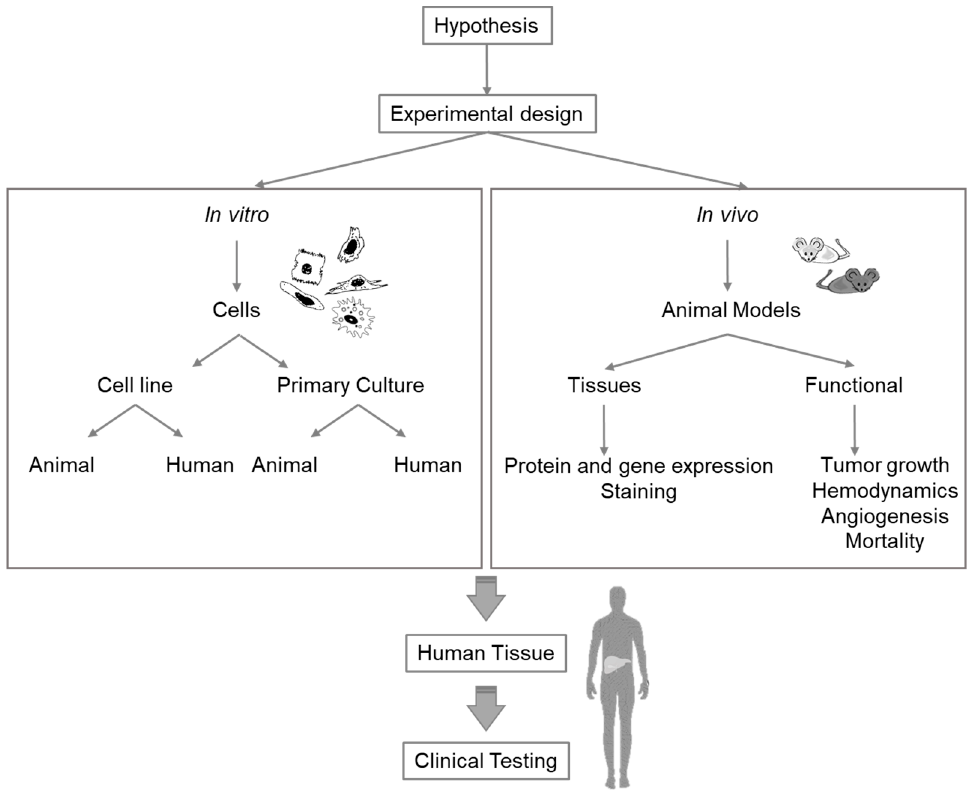
Figure 2. Diagram of considerations for selection of the appropriate experimental model for liver